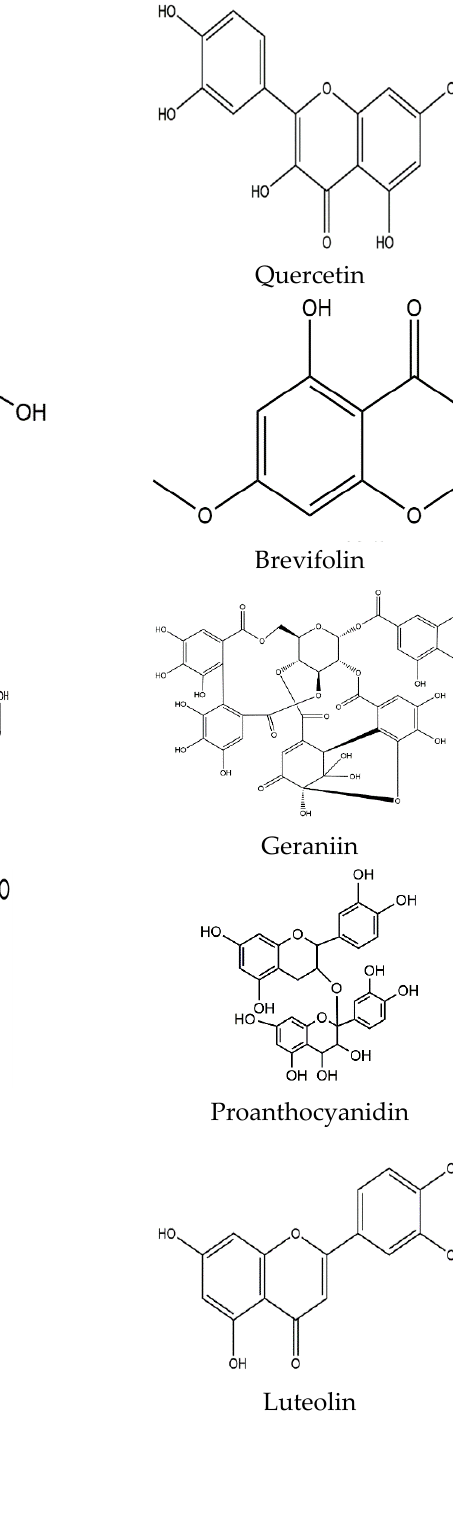
Figure 2. Diagrammatic representation of different chemical structures.